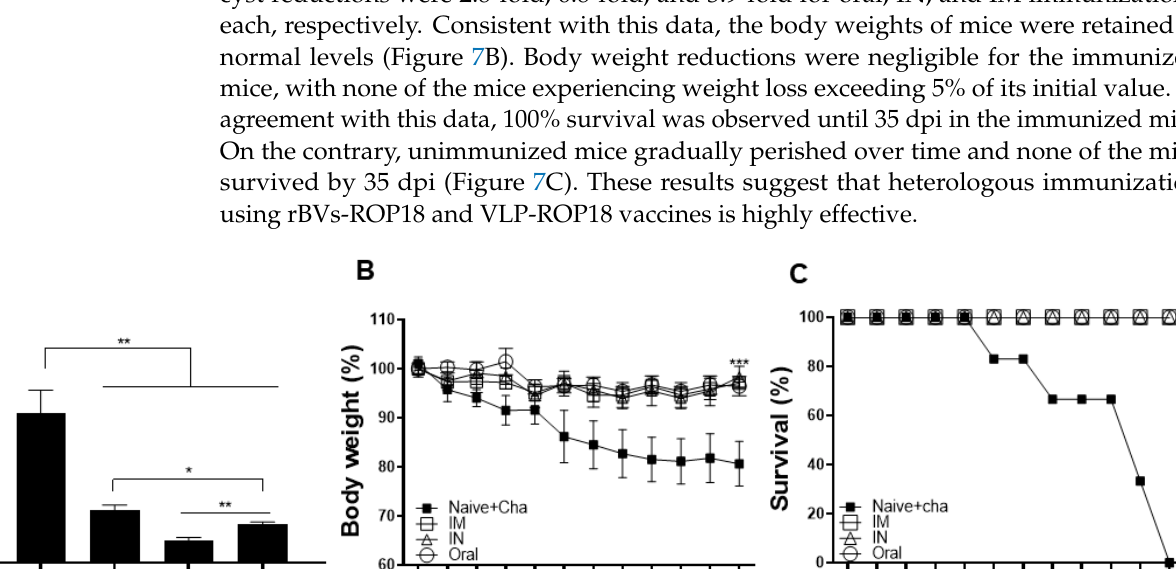
Figure 6. Brain tissues were collected from mice at 35 dpi with T. gondii ME49. The pro-inflammatory cytokines IFN- γ ( A ) and IL-6 ( B ) were measured from brain supernatants. Data are presented as mean ± SD and asterisks indicate statistical differences between groups. (* p < 0.1, ** p < 0.01, *** p < 0.001). All samples were acquired on an individual basis and a total of three independent experi- ments were performed in triplicates.